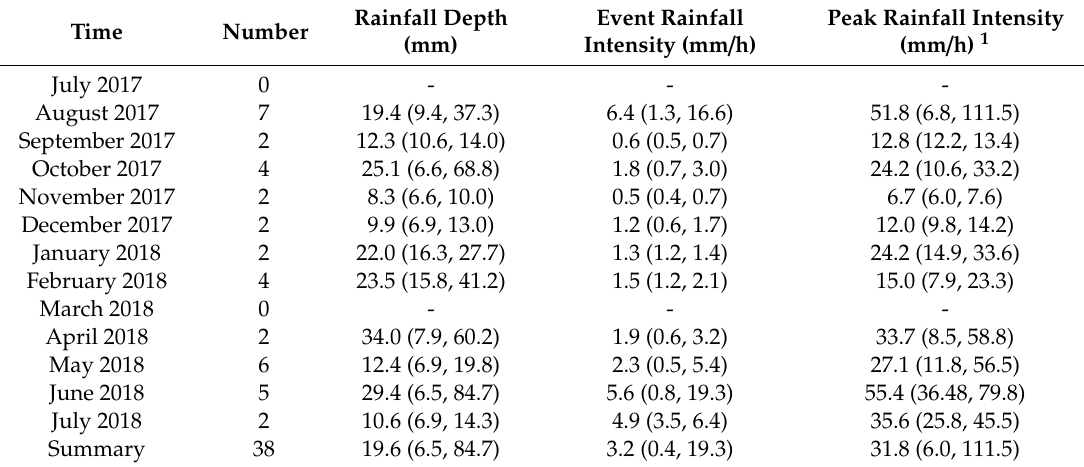
Table 1. Summary of storms for each month in the period of observation with values presented as “mean (min., max.)”.